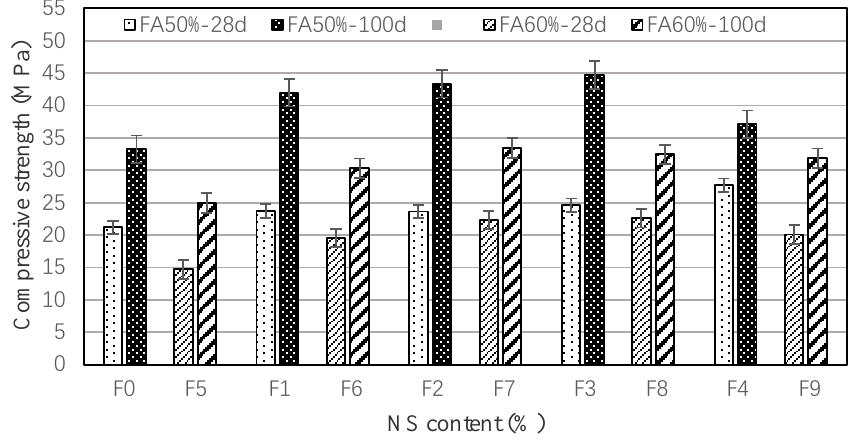
Figure 5. Flexural strength of NS-modified mortar.